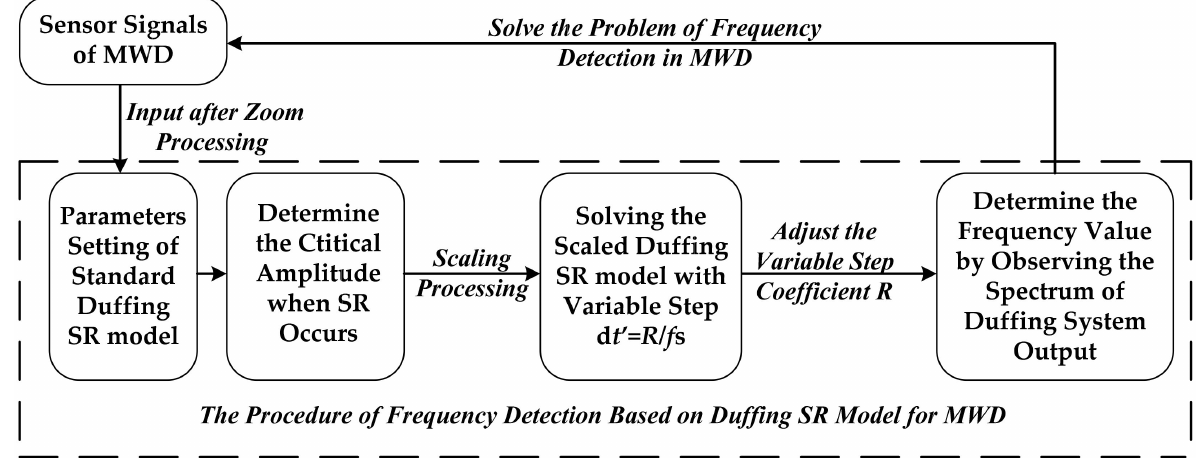
Figure 2. The procedure of frequency detection for MWD based on the SR of a variable-scale Duffing